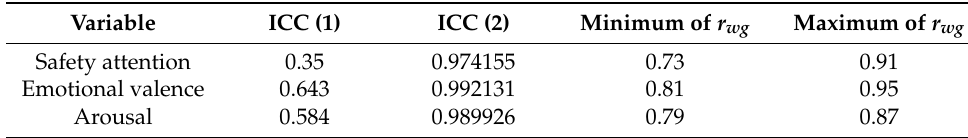
Table 4. Results of consistency and variability tests.